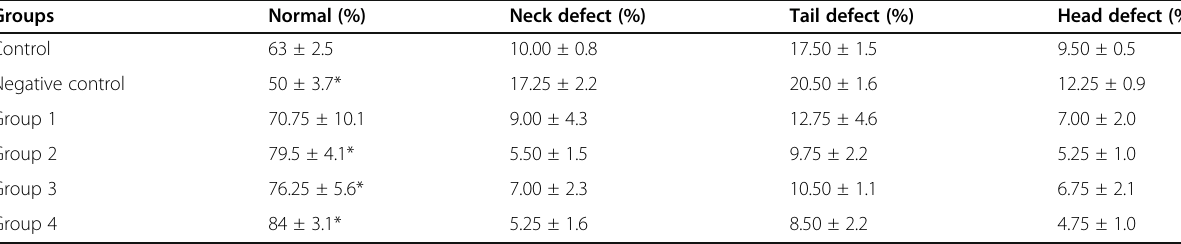
Table 2 Representation of sperm morphology Groups